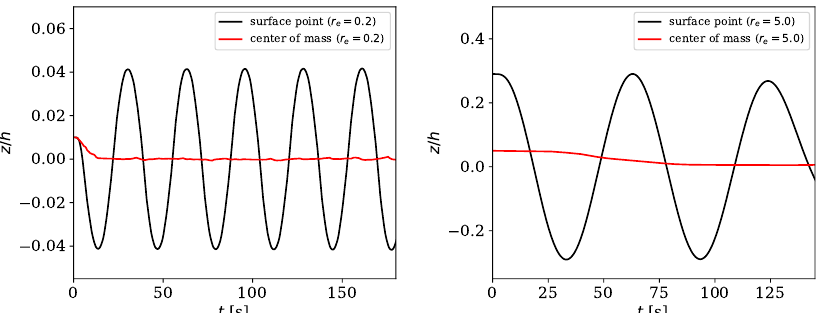
Figure 8. Motion of e z -coordinate over time t for two different aspect ratios (case a : r e = 0.2, case b : r e = 5.0).